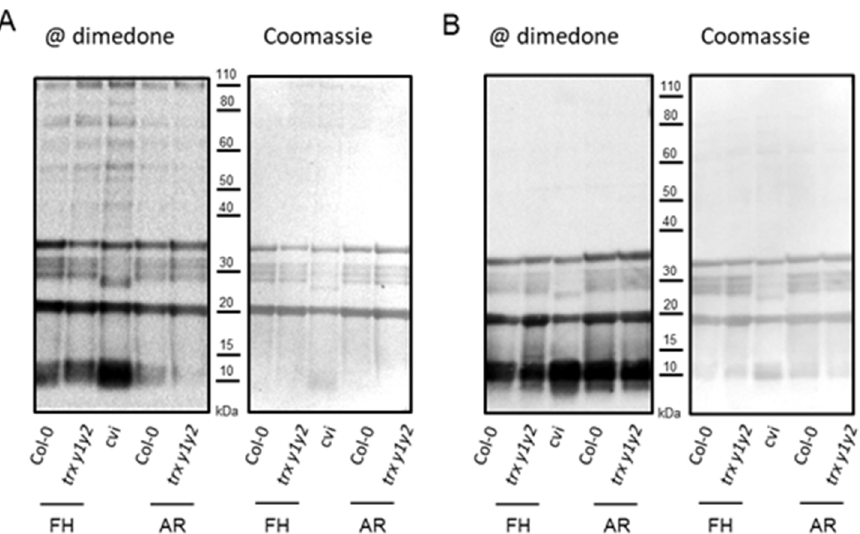
Figure 3. Protein cysteine oxidation in WT and trx y1y2 mutant seeds. Seeds were imbibed either ( A ) with water, or ( B ) in oxidative stress-triggering conditions (in presence of ascorbate 10 mM + CuSO 4 10 µM) in the dark for 24 h. Oxidized protein Cys residues (sulfenic acid form) were specifically immuno-detected after a labeling treatment using dimedone, SDS-PAGE, and Western blot chemiluminescence technology (left panel). For comparison between samples, Coomassie blue staining of the corresponding membrane is shown (right panel). Freshly harvested (dormant) (FH) seeds or 8-week after-ripened seeds (non-dormant) (AR), as well as Cape Verde Island (cvi) seeds were analyzed.